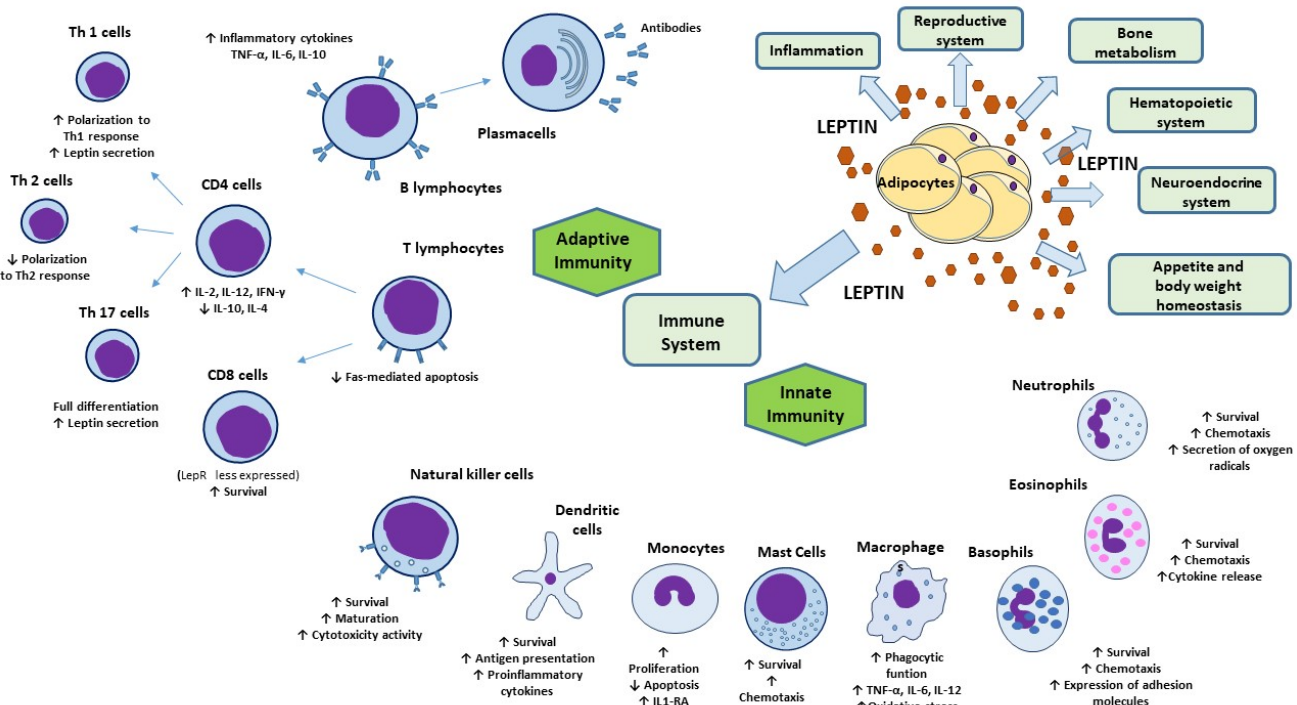
Figure 2. Physiologic functions of leptin and its effects on innate and adaptive immunity. Besides its key role in appetite and body weight homeostasis, leptin exerts physiological functions within immune, hematopoietic, neuroendocrine, and reproductive systems, as well as in bone metabolism and inflammation. In innate immunity, leptin modulates the activity and function of neutrophils, monocytes/macrophages, eosinophils, mast cells, NK cells, and DCs. In adaptive immunity, leptin affects the maturation and survival of T cells. On memory T cells leptin favors the switch toward Th1 cell responses and facilitate Th17 responses and, contrariwise, negatively affects the expansion of Treg. Leptin activates also B-cell responses. Abbreviations: DC, dendritic cells; IL, interleukin; IL1-RA, interleukin 1 receptor-agonist; IFN-γ, interferon-γ; NK, natural killer; Th, T helper; TNF-α, tumor necrosis factor-α; Treg, regulatory T cells.